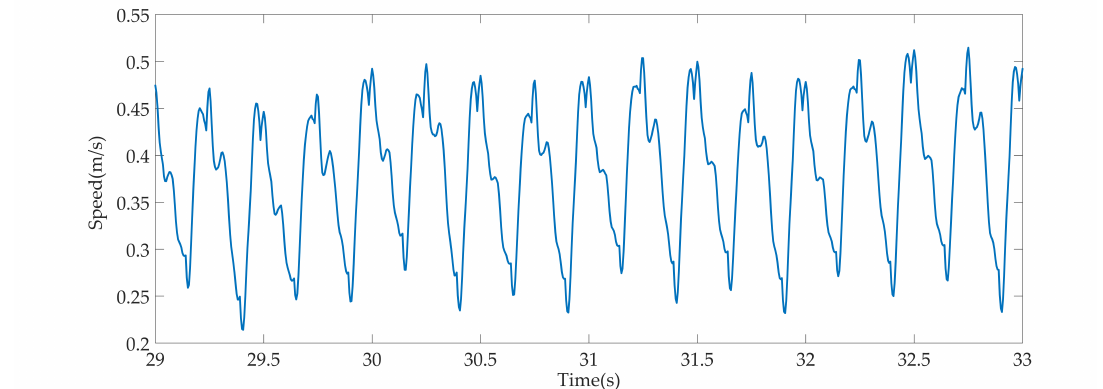
Figure 13. Physical prototype actual trotting forward